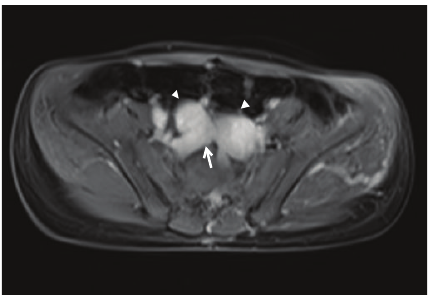
Figure 8: A 9-year-old boy with bleeding per rectum since he was 1 year old. Axial MR image reveals abnormal vascular channels in the pelvis suggesting a communication between tributaries of superior mesenteric vein (arrow head) and iliac veins (arrow).